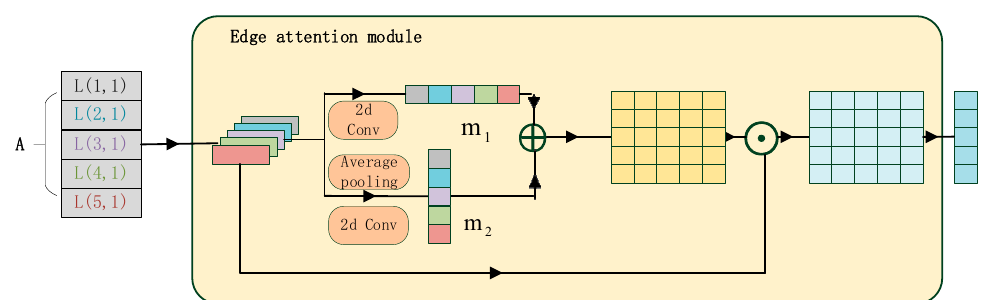
Figure 2. Edge attention generation network. Different color blocks represent different features. A is the adjacency matrix.